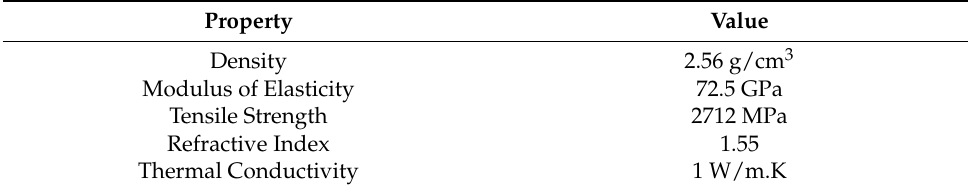
Table 2. The mechanical and physical characteristics of E-glass